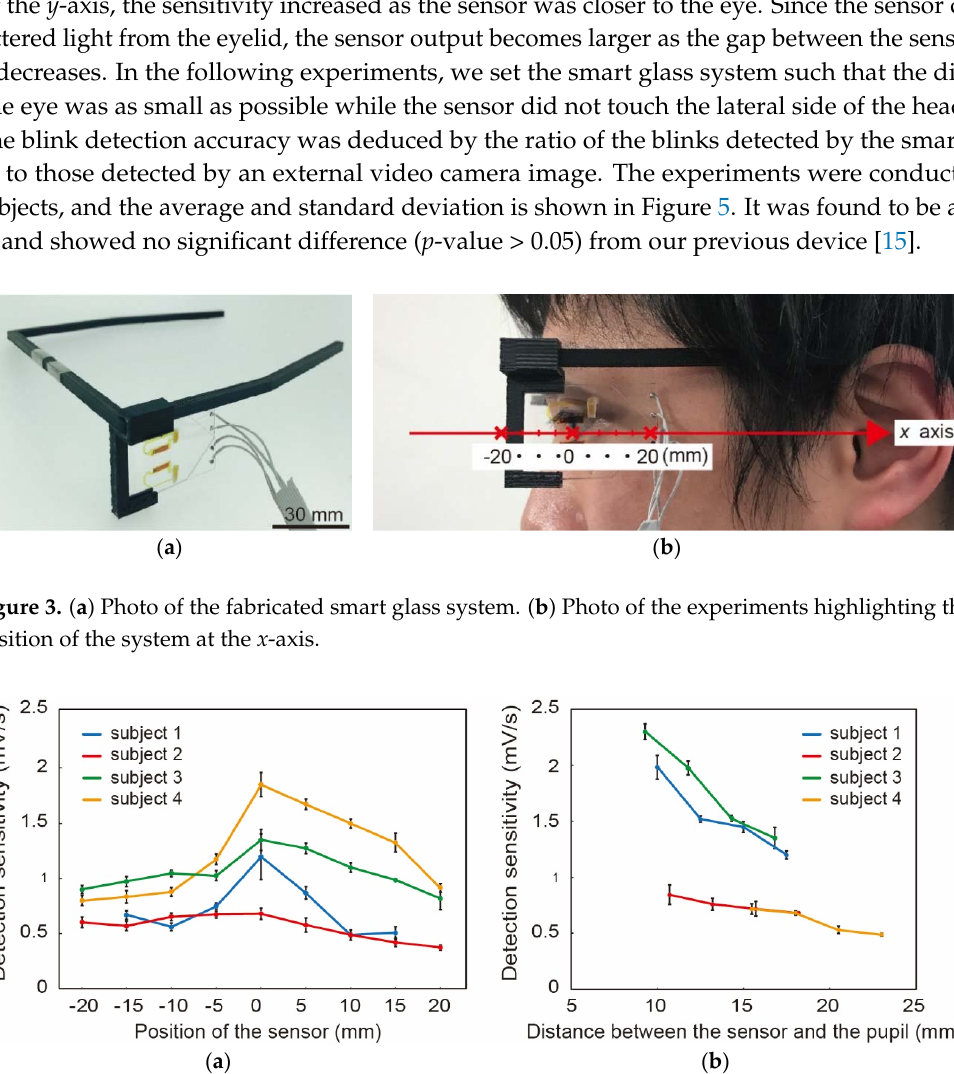
Figure 4. Detection sensitivities with respect to the sensor position at the ( a ) x -axis and ( b ) y -axis. Four subjects conducted experiments four times for each condition. The optimal position on the x -axis was found to be x = 0 (i.e., the lateral to the eye). On the y -axis, the sensitivity increased as the sensor was located closer to the eye. The error bars represent the standard deviation.